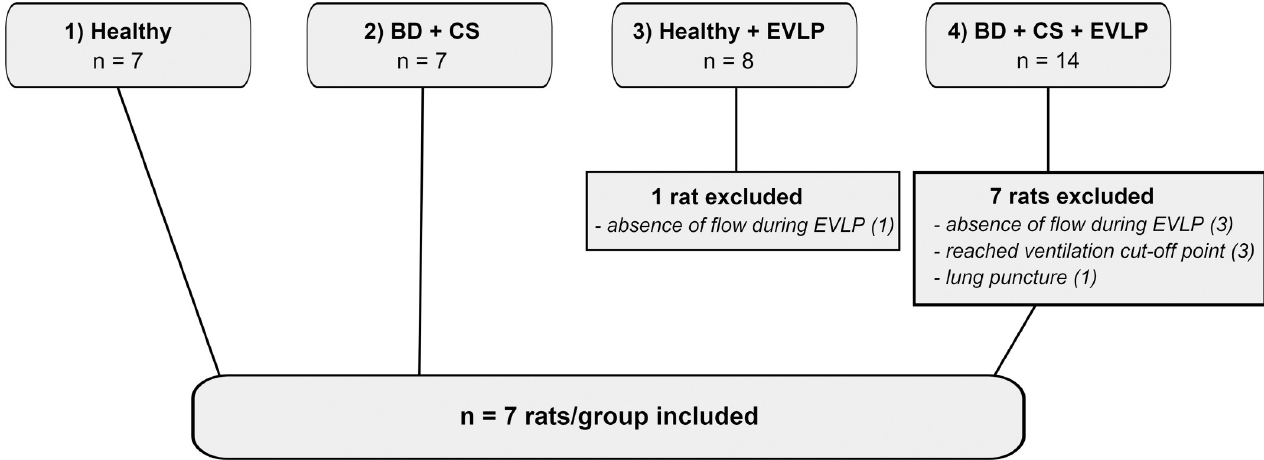
Fig 3. Experimental groups with number of rats utilized and rationale for exclusion. Lungs from donor rats were randomly assigned to one of four experimental groups (n = 7/group): 1) healthy, directly procured lungs, 2) lungs procured from rats subjected to 3 hours of brain death (BD) and 1 hour cold storage (CS), 3) healthy, directly procured lungs subjected to 6 hours ex vivo lung perfusion (EVLP) and 4), lungs procured from rats subjected to 3 hours of BD, 1 hour CS and 6 hours EVLP. In total, 38 rats were utilized for the establishment of a stable BD and EVLP protocol, of which 10 rats were excluded. Eventually, 7 rats per group were included in the final